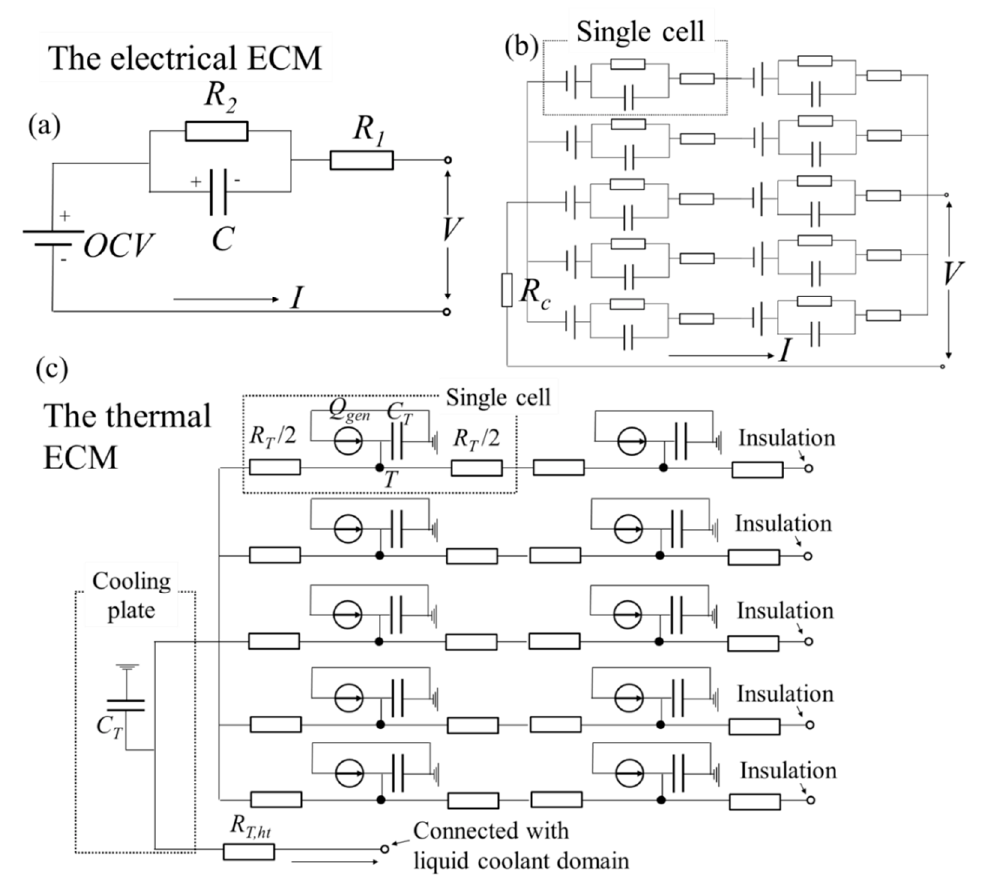
Figure 1. The schematic views of ( a ) the electrical equivalent circuit model (ECM) for a single cell, ( b ) the electrical ECM for the whole battery pack, and ( c ) the thermal ECM for the whole battery pack.